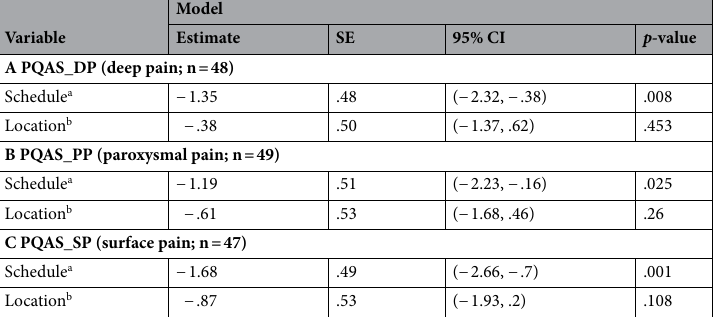
Table 4. Ordinary least squares (OLS) regression results for PQAS subscales (secondary outcomes) at Week 10 (end of study). a 2X per week (Group 2 + Group 4) vs 3X per week (Group 1 + Group 3); 2X per week used as reference. b Lower extremity (Group 1 + Group 2, intervention) versus head/neck/shoulder massage (Group 3 + Group 4, control); head/neck/shoulder used as reference.